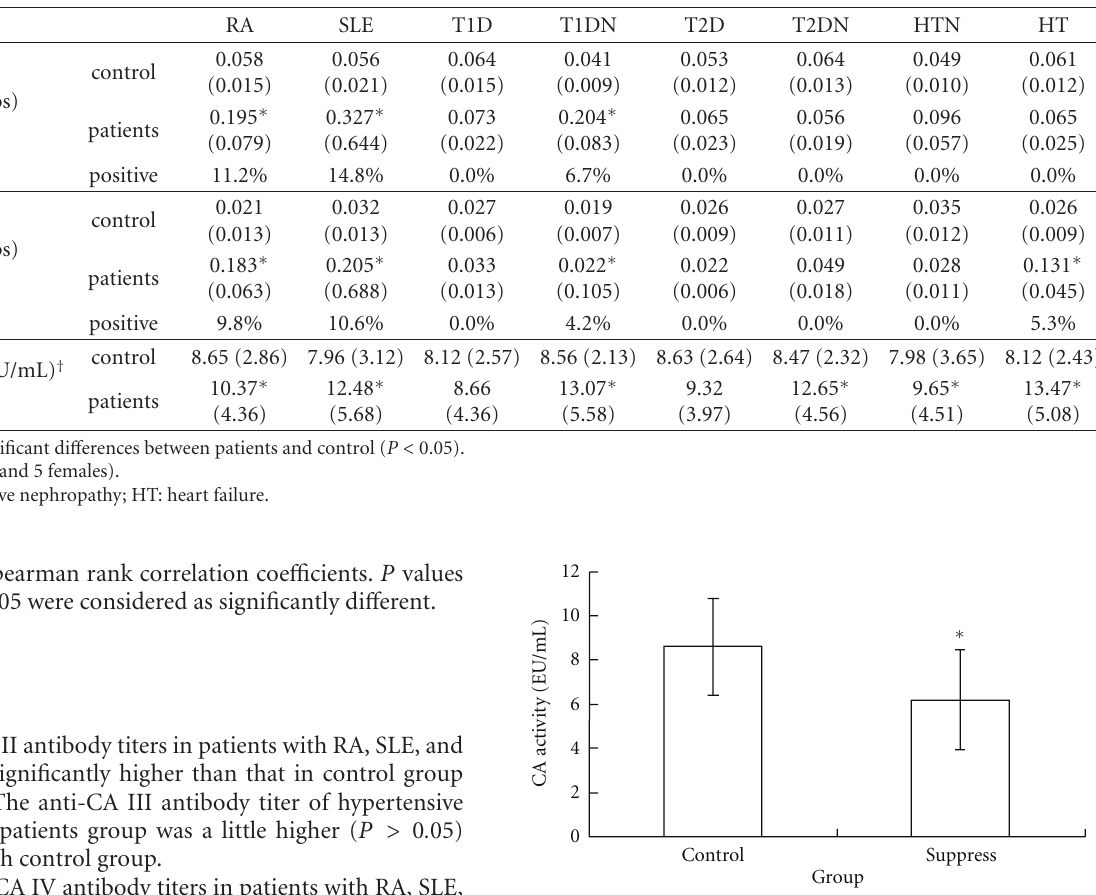
Figure 1: The total CA activity was suppressed by anti-CA IV antibody. ∗ There was significant di ff erence between suppress group and control group ( n = 5) ( P < 0 .